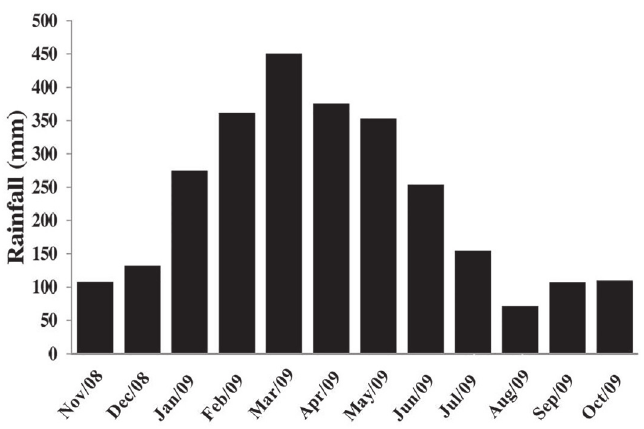
Figure 4 - Average rainfall in the Água Preta lake area for the period from November 2008 to October 2009. Source: SECTAM